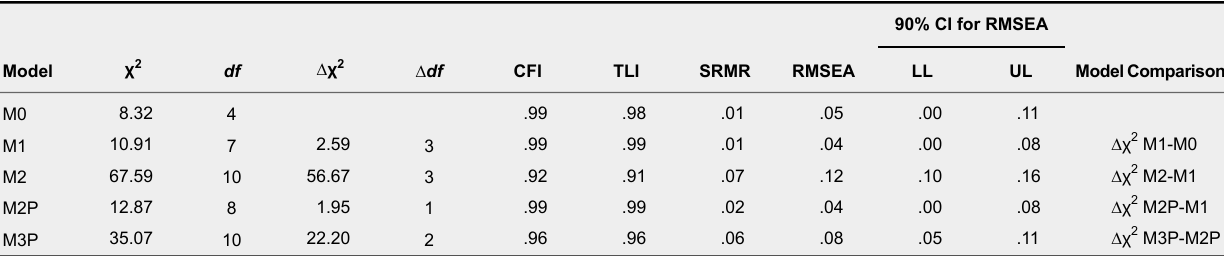
Goodness-of-fit Indices and Comparison of Models Testing Measurement Invariance for Government Openness